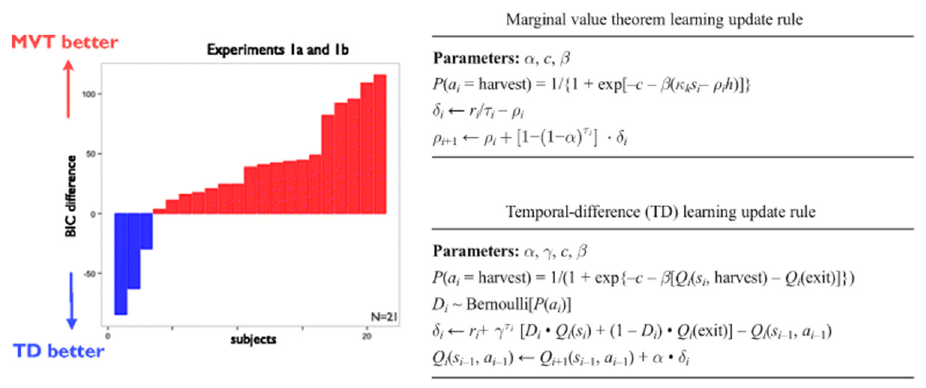
Figure 5. Model Comparison between Temporal Difference Learning and Marginal Value Theorem. (Left) The panel shows the Bayesian information criterion (BIC) result of the model comparison between the model of Marginal Value Theorem (MVT) and the model of temporal difference (TD) learning. The TD model is similar to the simple RL model in Figure 4. The red bars with values above zero refer to the subjects whose behaviors are better explained by the model of MVT, whereas the blue bars with negative values refer to the subjects whose behaviors are explained better by the model of temporal difference learning. (Right) These two tables summarize the MVT and TD models that were compared in the left plot. The MVT model optimizes undiscounted reward rate, whereas TD optimizes cumulative exponentially discounted reward with a free discount rate. For more detailed model information, see Constantino and Daw [95]. (Image adapted with permission from Constantino and Daw, Cognitive, A ff ective, & Behavioral Neuroscience, 2015; Springer